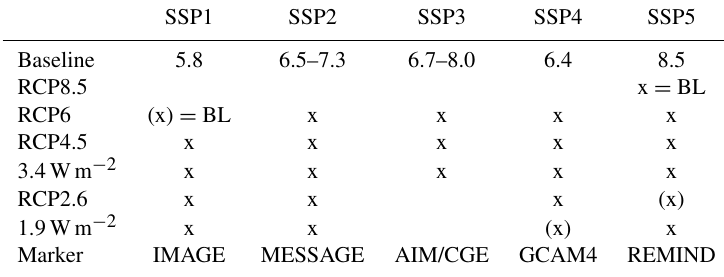
Table 1. Forcing levels attained by SSPv2 studies. See Riahi et al. (2017), Calvin et al. (2017), and Rogelj et al. (2018). For SSP1, RCP6 is the baseline forcing for all models except WITCH (World Induced Technical Change Hybrid), which has a slightly higher baseline (BL) such that RCP6 is a mitigation scenario. “x” means that the forcing level could be attained by all models that implemented it, and “(x)” means that it could be attained by at least one model but not in the marker implementation. All forcings in Wm − 2 .